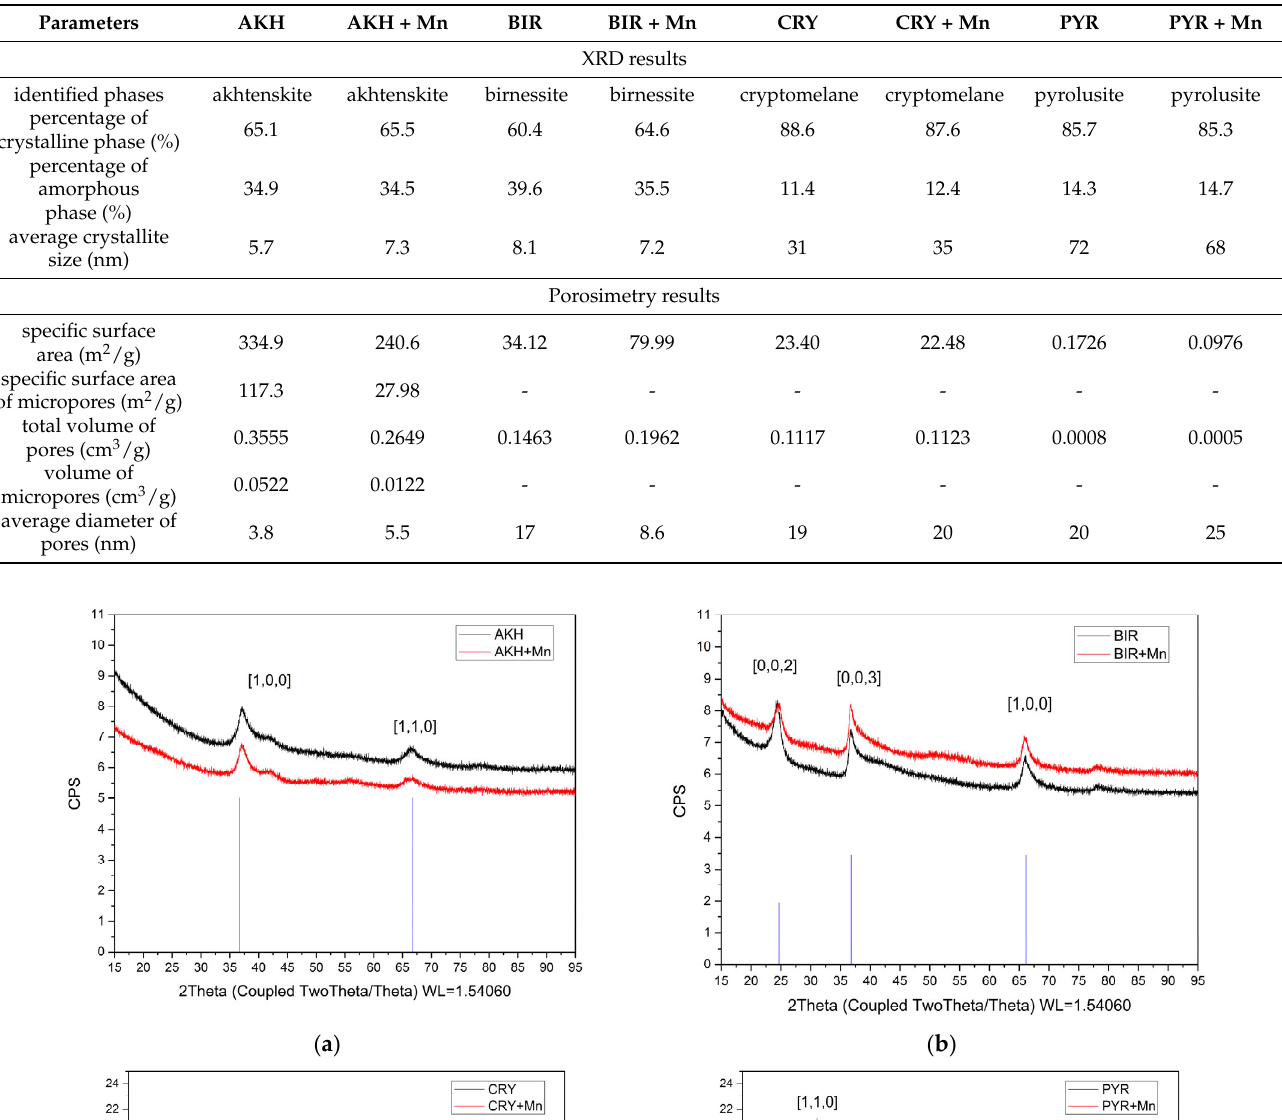
Table 1. Characteristics of manganese dioxide (MnO 2 ) polymorphs before and after manganese (Mn) adsorption.